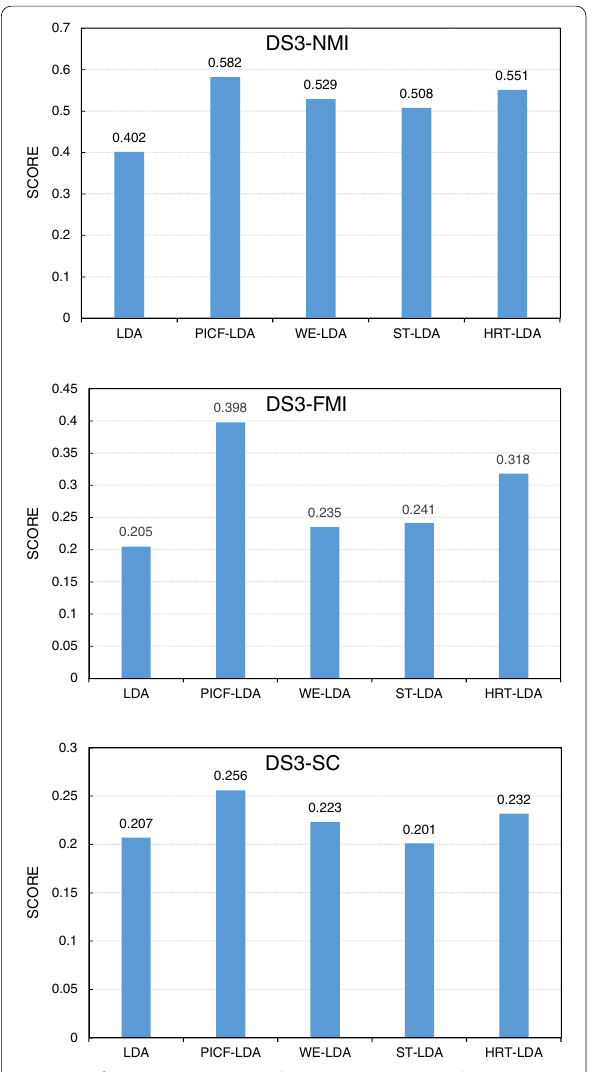
Fig. 7 Performance comparison between PICF-LDA and variant LDA models in DS3 Table 3 Performance improvement of PCIF-LDA and variant LDA models